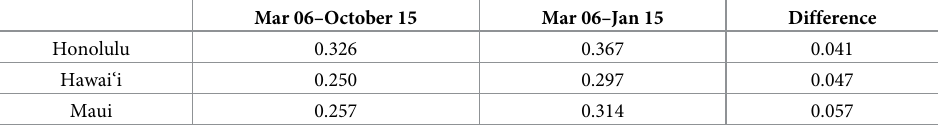
Table 5. Means for perturbed normalized L 2 norms and their differences for Hawaiian counties computed over the time periods until Oct. 15 and until Jan